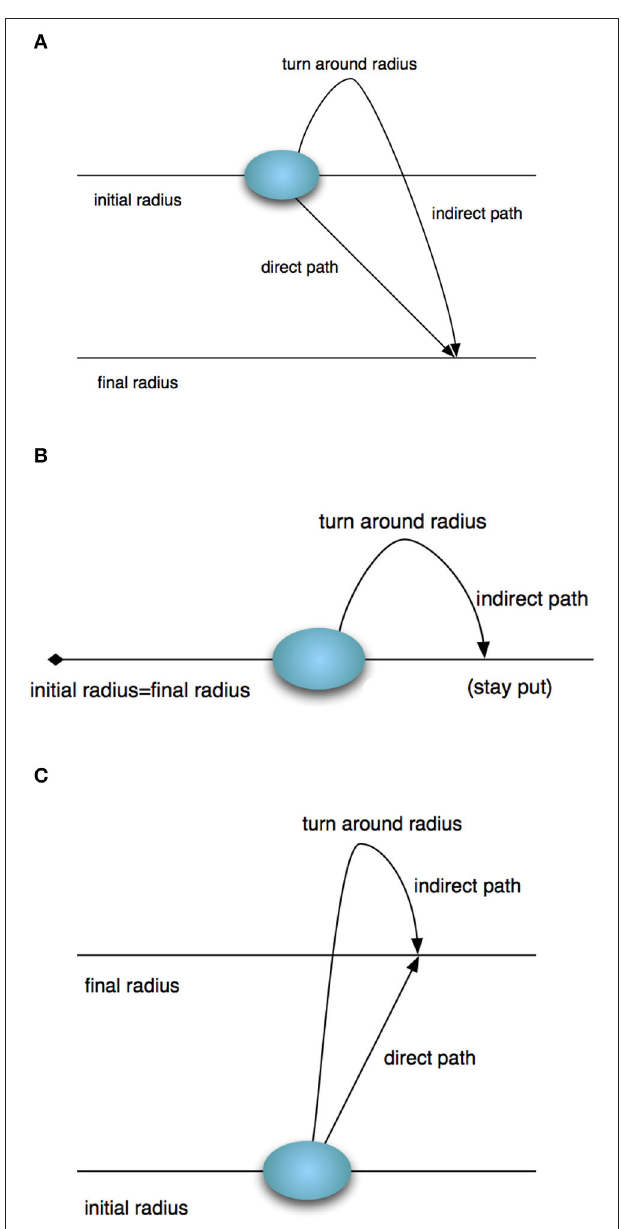
FIGURE 1 | Schematic of paths. (A) r f < r i , (B) r f